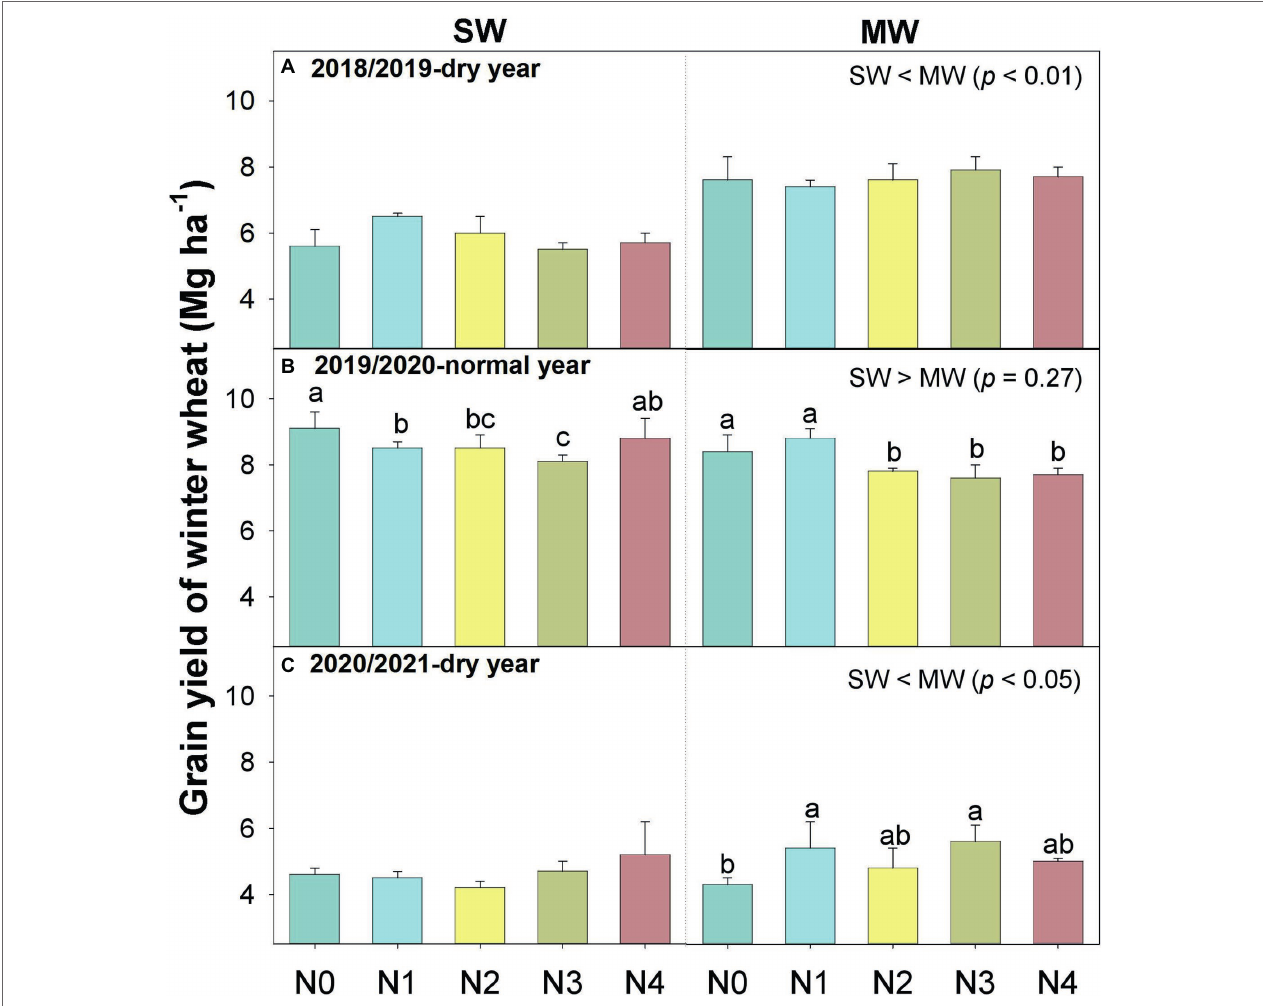
FIGURE 4 | Grain yield of winter wheat in summer soybean–winter wheat (SW) and summer maize–winter wheat (MW) rotation systems under five N application rates. Values are means + SEs ( n = 3). Different lowercase letters indicate significant differences ( p < 0.05) among five fertilization treatments within the same